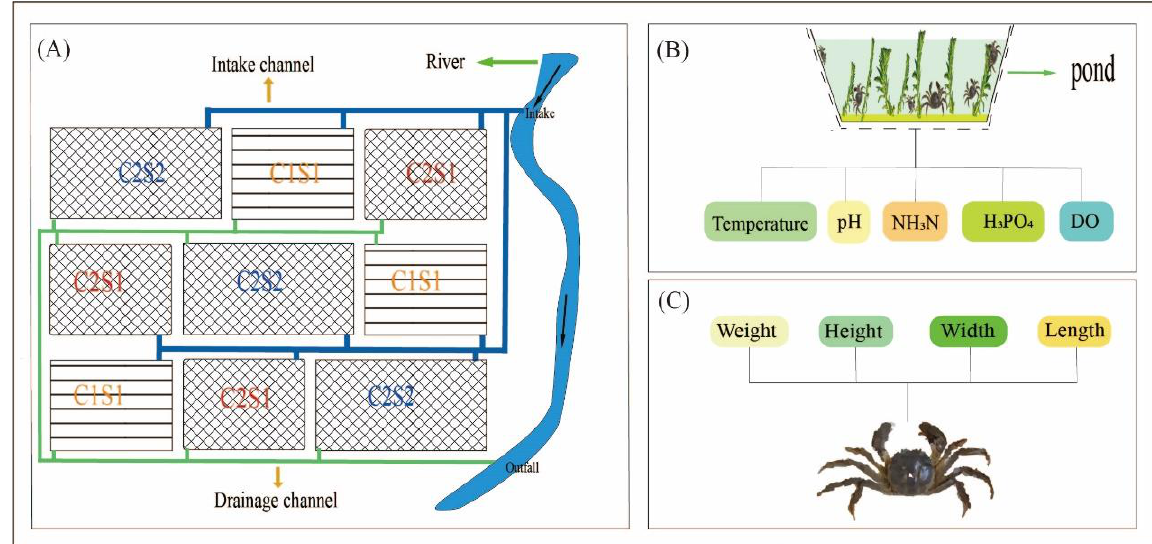
Figure 1. Schematic diagram of experimental design ( A ), quality indicators of water environmental ( B ) and indicators of Eriocheir sinensis ( C ).